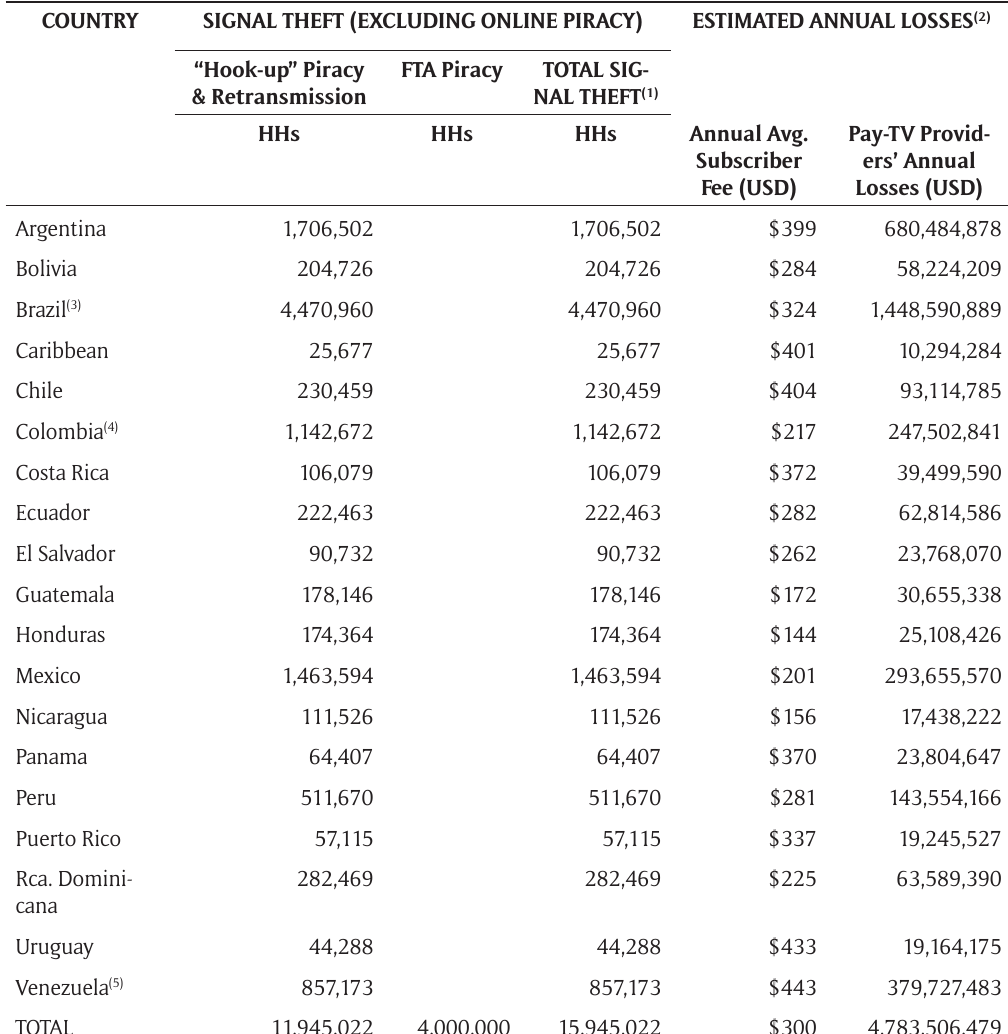
Table 2: Pay-TV losses caused by signal theft (excluding online